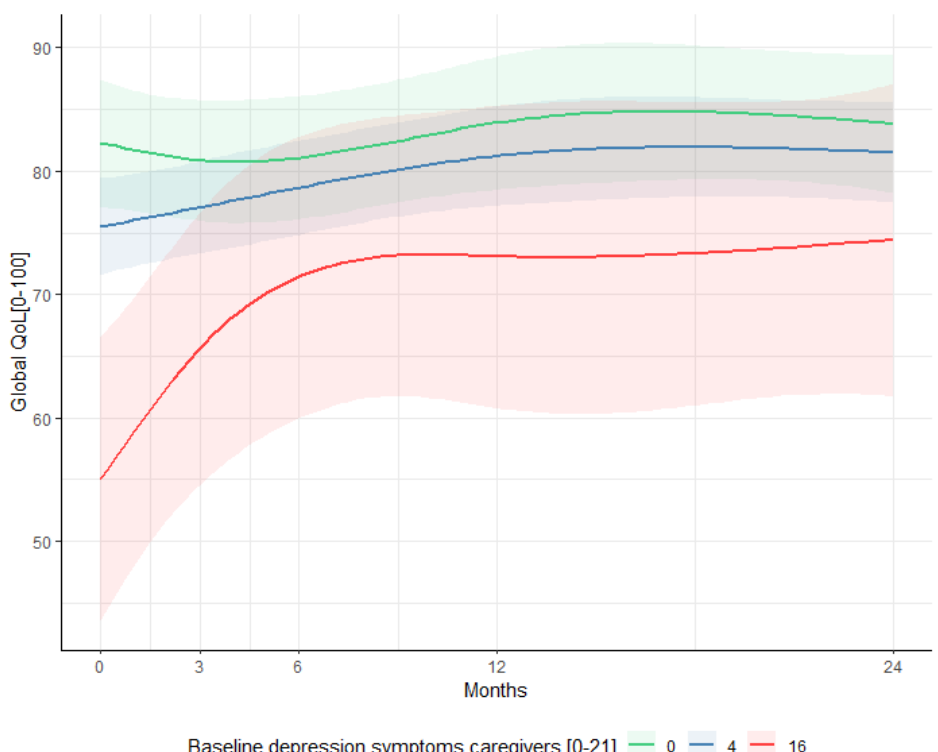
Figure 2. The association between depression symptoms of caregivers at baseline with global QoL of patients at all time points. The red line indicates QoL of patients over time when at baseline depression was the highest score in our cohort (HADS depression = 16), the blue line indicates the mean depression symptoms of caregivers in our cohort (HADS depression = 4), and the green line indicates no symptoms of depression (HADS depression = 0). The 95% confidence interval of the predicted anxiety and depression scores are presented in the lighter color. Outcomes were calculated with a linear mixed model, adjusted for gender, age, education level, disease stage, comorbidity and WHO status, and caregivers’ baseline Caregiver Reaction Assessment (CRA) and Hospital Anxiety and Depression Scale (HADS) outcomes.